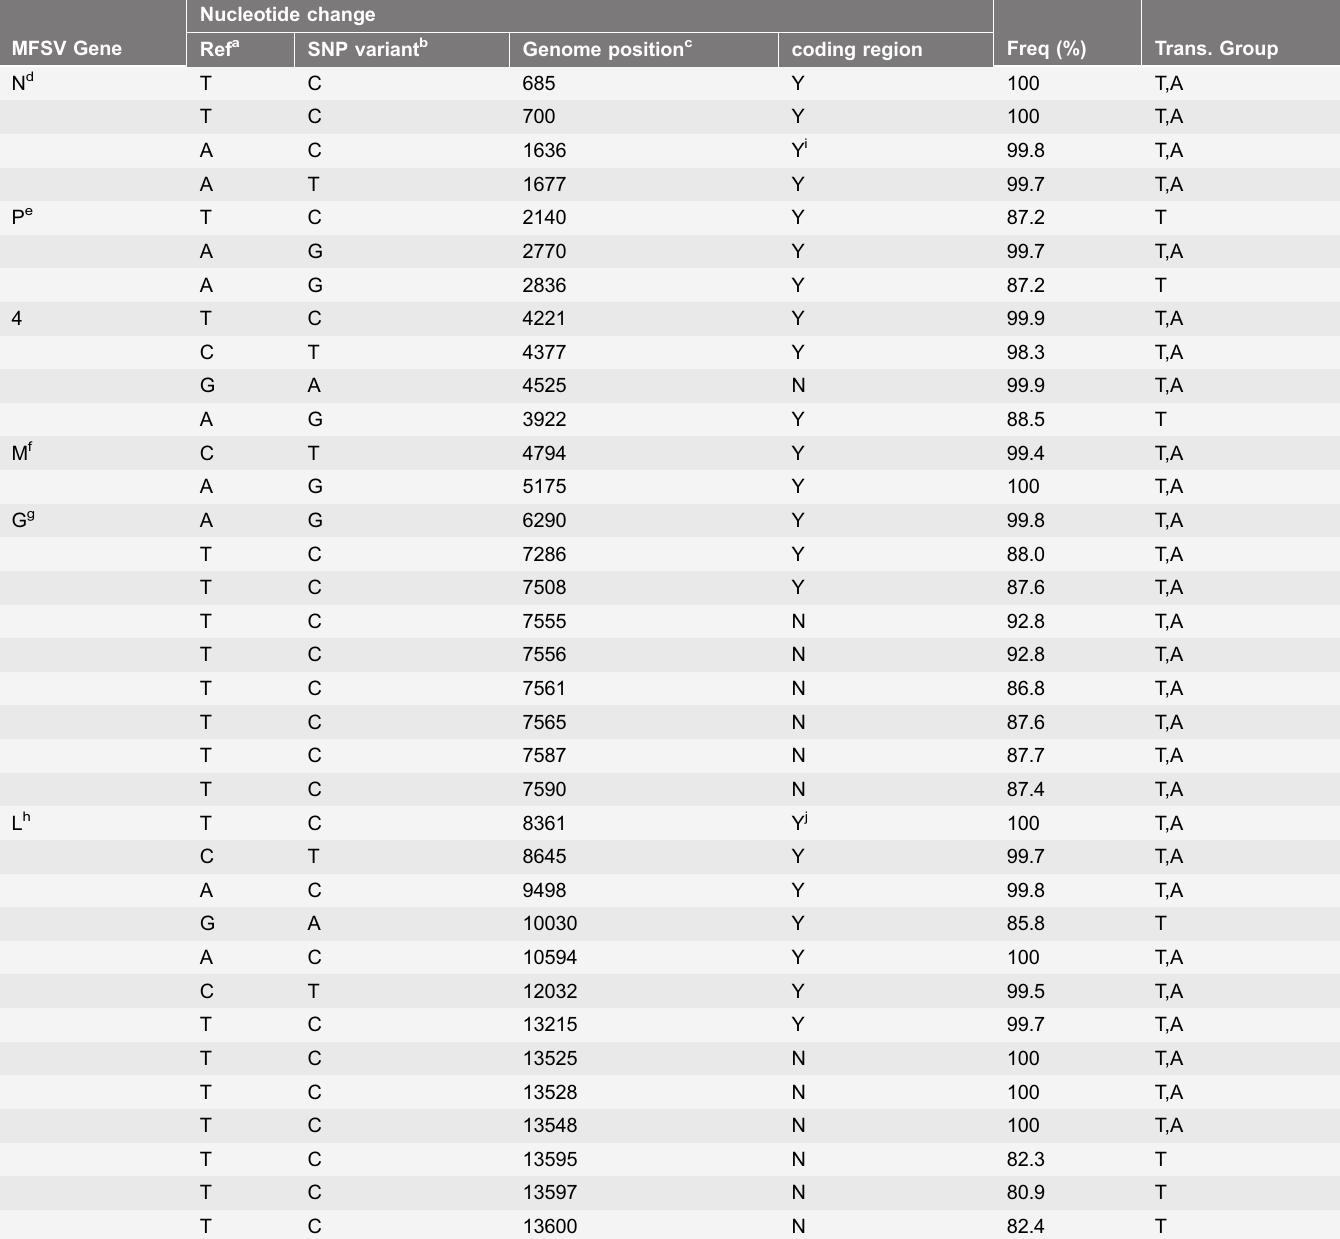
Table 3. MFSV sequence divergence between G. nigrifrons transmission groups a . Nucleotide MFSV Gene